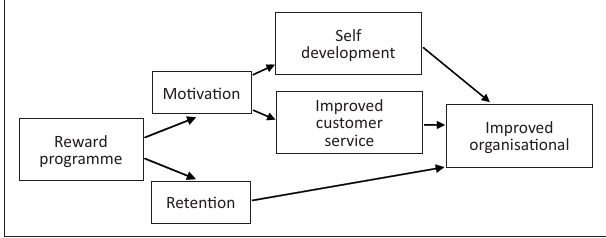
FIGURE 3: Plausible programme theory for a reward